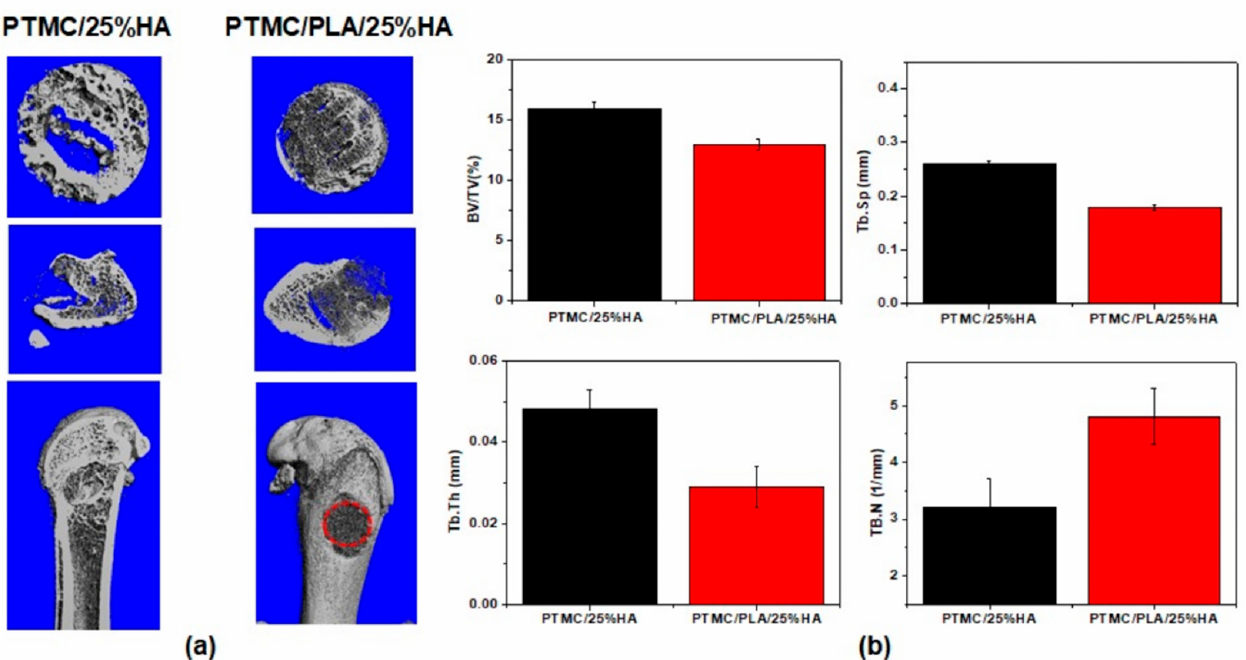
Figure 9. Micro-CT analysis of the effect of scaffolds on femur defect in vivo. ( a ) Representative three-dimensional reconstructed micro-CT images showing the effect of PTMC/25%HA and PTMC/PLA/25%HA scaffolds on the new bone tissue formation inside the defect site (red dashed line). (Left: PTMC/25%HA scaffolds after 2 months, right: PTMC/PLA/25%HA scaffolds after 2 months.) ( b ) Summarized data showing the micro-architectural parameters of the new formed bone tissue at 2 months by analyzing the three-dimensional reconstructed micro-CT images using image analysis software. BMD, BV/TV, Tb.Th, and Tb.N were shown in the panel.